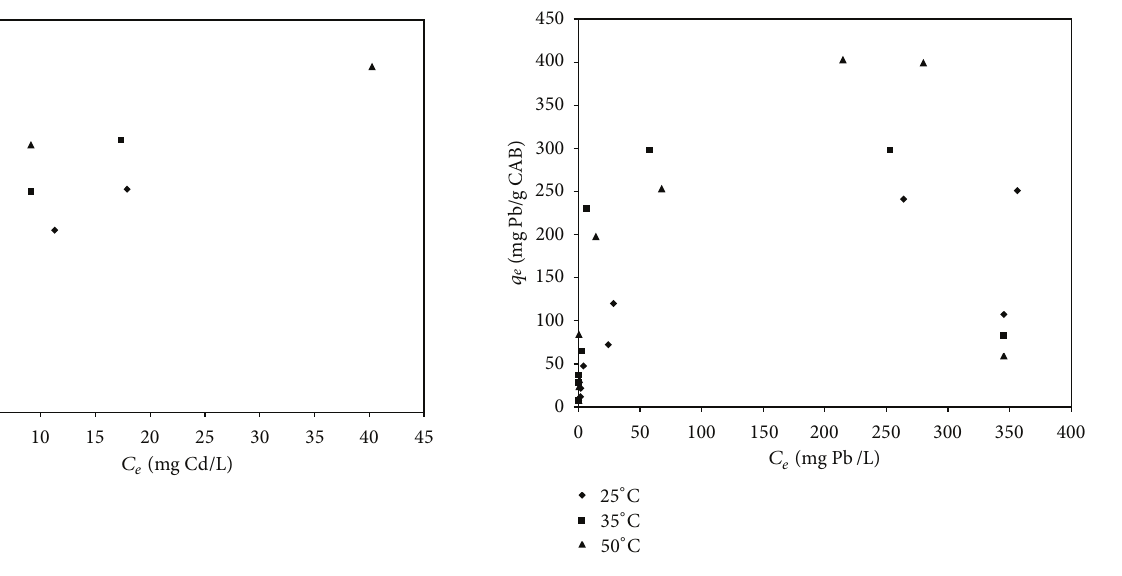
Figure 6: Isotherms of cadmium biosorption by CAB at 25 ∘ C, 35 ∘ C, and 50 ∘ C.